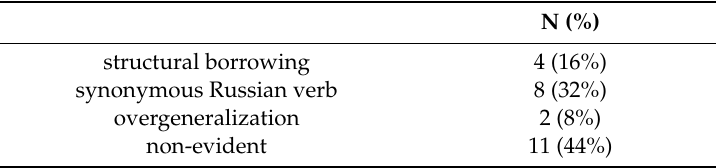
Table 5. Types of overuses (Tungusic and